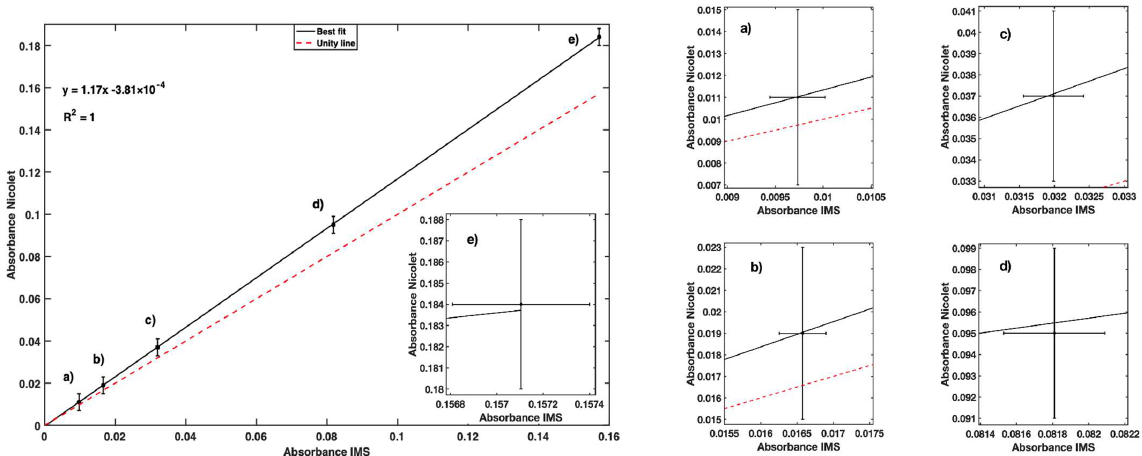
Figure 11. Fe 2+ absorbance for different standard samples obtained by IMS instrument and reference Nicolet Evolution 300 spectrophotometer. Zoom-in of points is provided for better representation of error bar. For each point on the left chart, a corresponding magnified chart is presented on the right. The unity line in the plot on the left in Figure 11 highlights the overestimation of 14.6% compared with the absorbance values measured with the Nicolet Evolution 300.